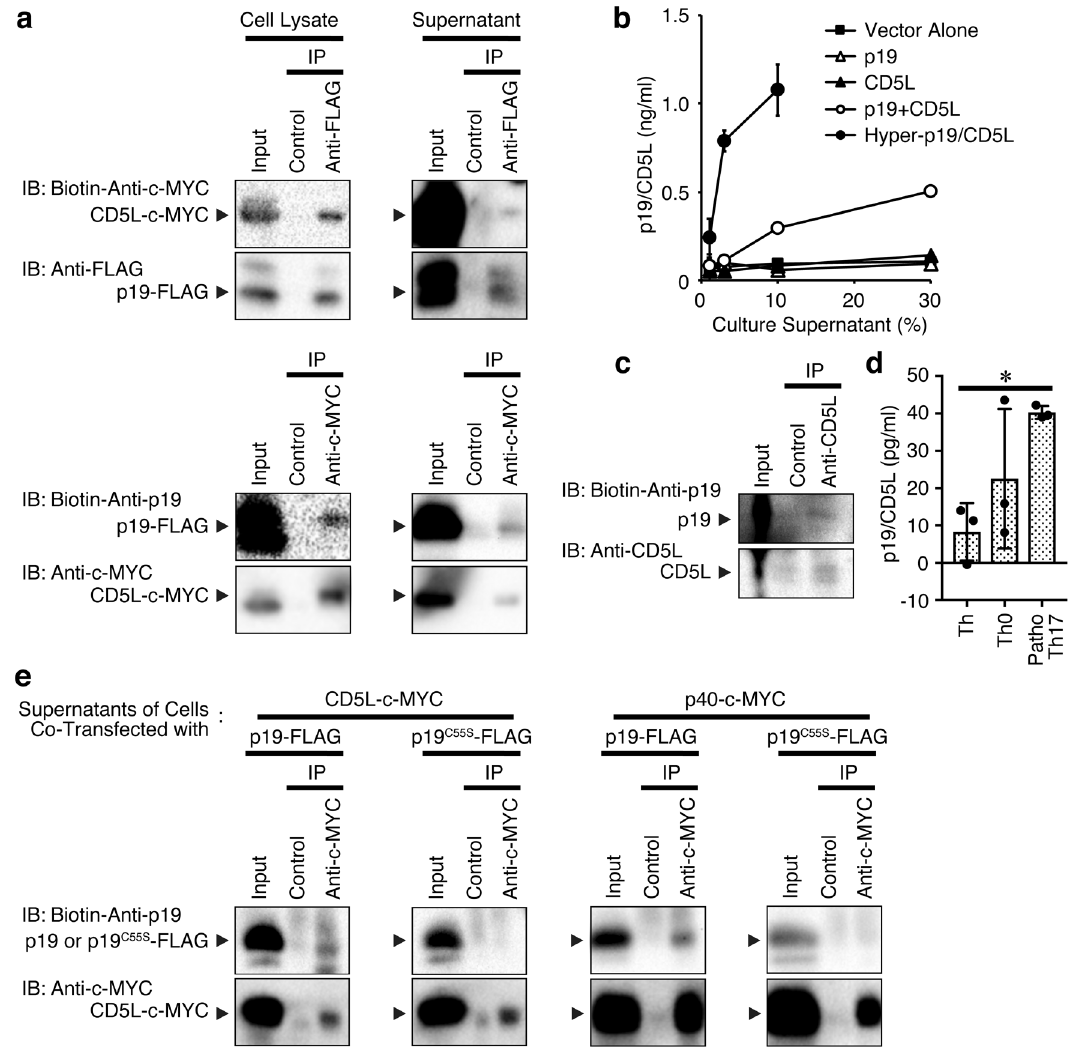
Figure 4. p19 associates with CD5L to form a putative heterodimer of p19/CD5L. ( a ) HEK293-F cells were transiently cotransfected with p3 × FLAG-CMV-14-p19 and pCMV3-CD5L-c-MYC and cultured for 3 days, and total cell lysates or culture supernatants were immunoprecipitated with anti-FLAG or anti-c-MYC and control antibody followed by western blotting with biotin-conjugated anti-c-MYC or biotin-conjugated anti-p19, respectively. Immunoprecipitated protein was confirmed by western blotting with the antibody used for immunoprecipitation. ( b ) HEK293T cells were transiently transfected with the control vector p3 × FLAG- CMV-14 alone, p3 × FLAG-CMV-14-p19, pCMV3-CD5L-c-MYC, or both and p3 × FLAG-CMV-14-Hyper-p19/ CD5L, then cultured for 3 days. The culture supernatants were then subjected to p19/CD5L-specific ELISA in triplicate. Data are shown as the mean ± SD. ( c ) Naive CD4 + T cells were stimulated with plate-coated anti-CD3 (5 μg/ml) and anti-CD28 (2 μg/ml) under pathogenic Th17-polarizing conditions for 3 days. Resultant culture supernatants were collected and concentrated by centrifugation using a centrifugal filter approximately 8 times, and subjected to immunoprecipitation with anti-CD5L followed by western blotting with biotin-conjugated anti-p19 and subsequently anti-CD5L. ( d ) Naive CD4 + T cells were also similarly stimulated with plate-coated anti-CD3 and anti-CD28 under Th, Th0 and pathogenic Th17-polarizing conditions for 3 days. Resultant culture supernatants were collected and concentrated by centrifugation using a centrifugal filter approximately 10 times, followed by p19/CD5L-specific ELISA in triplicate. ( e ) HEK293-F cells were transiently cotransfected with p3 × FLAG-CMV-14-p19 WT or p3 × FLAG-CMV-14-p19 C55S and pCMV3-CD5L-c-MYC and cultured for 3 days. The culture supernatants were immunoprecipitated with anti-c-MYC and control antibody followed by western blotting with biotin-conjugated anti-p19, then anti-c-MYC. Data are shown as the mean ± SD and representative of four ( a ) or two ( b – e ) independent experiments. P values were determined using one-way ANOVA. * P <